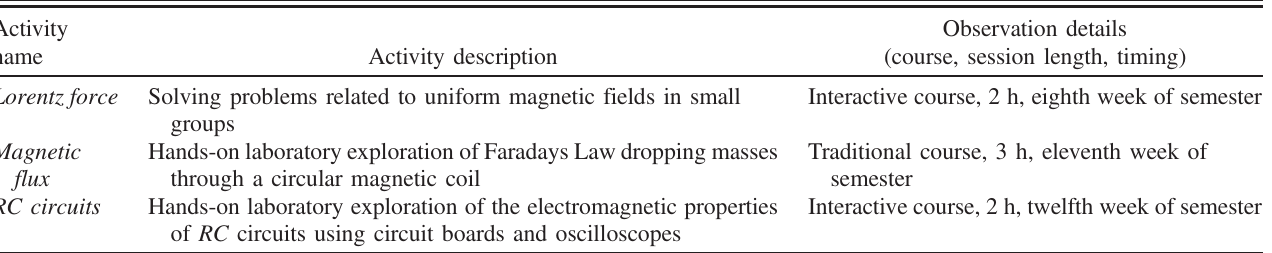
TABLE I. Summary of the classroom activities we